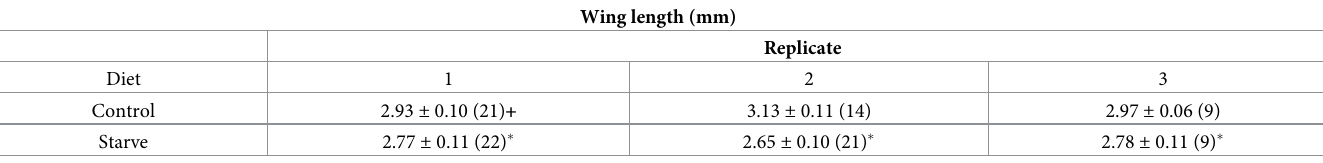
Table 1. Mean wing lengths (mm) ± standard deviation (SD) of adult Ae . aegypti (HWE) reared under Control and Starve diet regimen in three replicates.